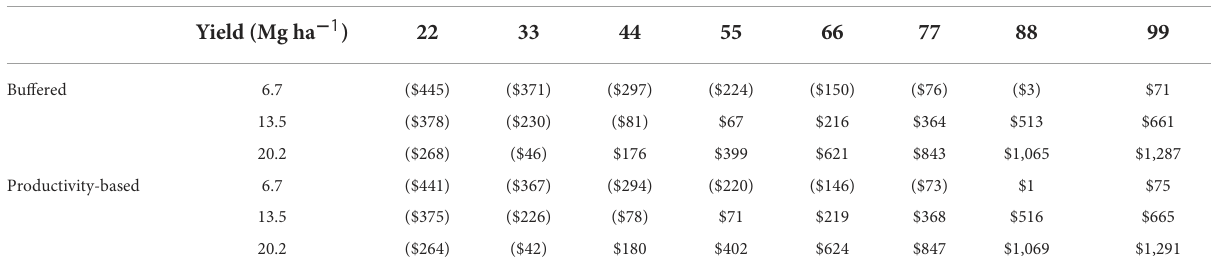
− 1 Bioenergy grassland biomass price ($ Mg )